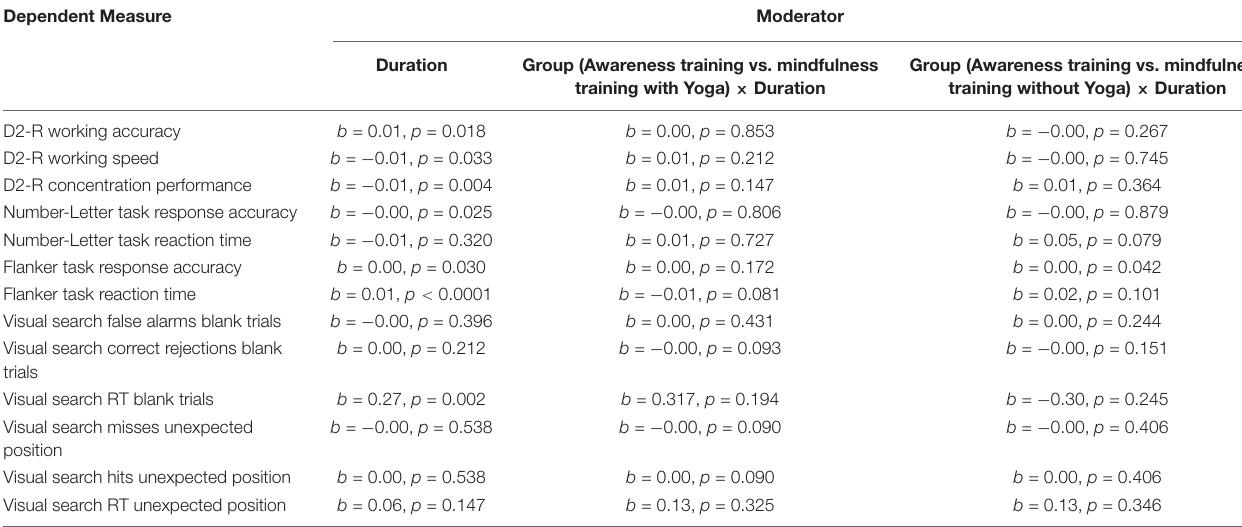
TABLE 4 | Moderation analyses comparing the effect of homework duration in all three treatment groups (mindfulness training with yoga, mindfulness training without yoga, and active control group). Dependent